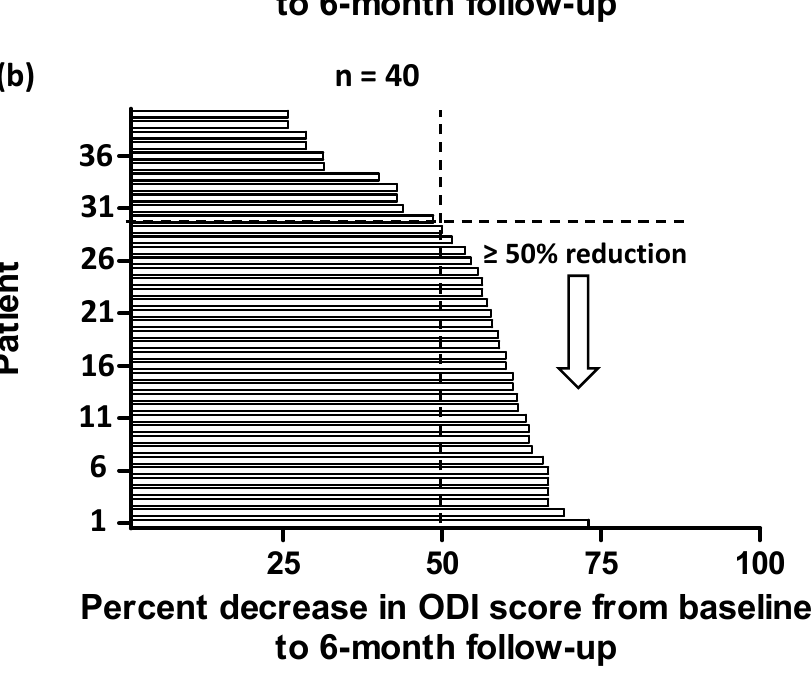
Figure 2. Individual responses in VAS ( a ) and ODI score ( b ) at 6 months after treatment, quantified by percent change from the baseline values.